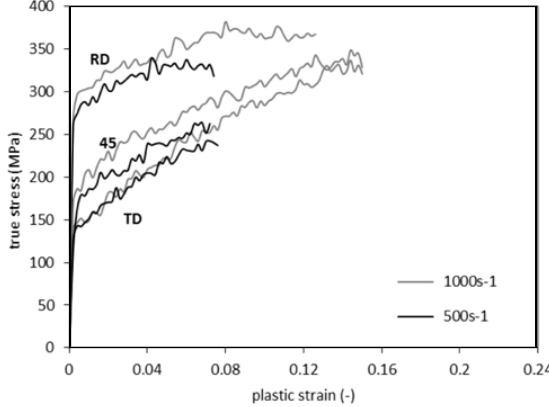
Fig. 8. E ff ect of orientation on UTS and YS for ZEK100 sheet at a strain rate of 0 . 1s − 1